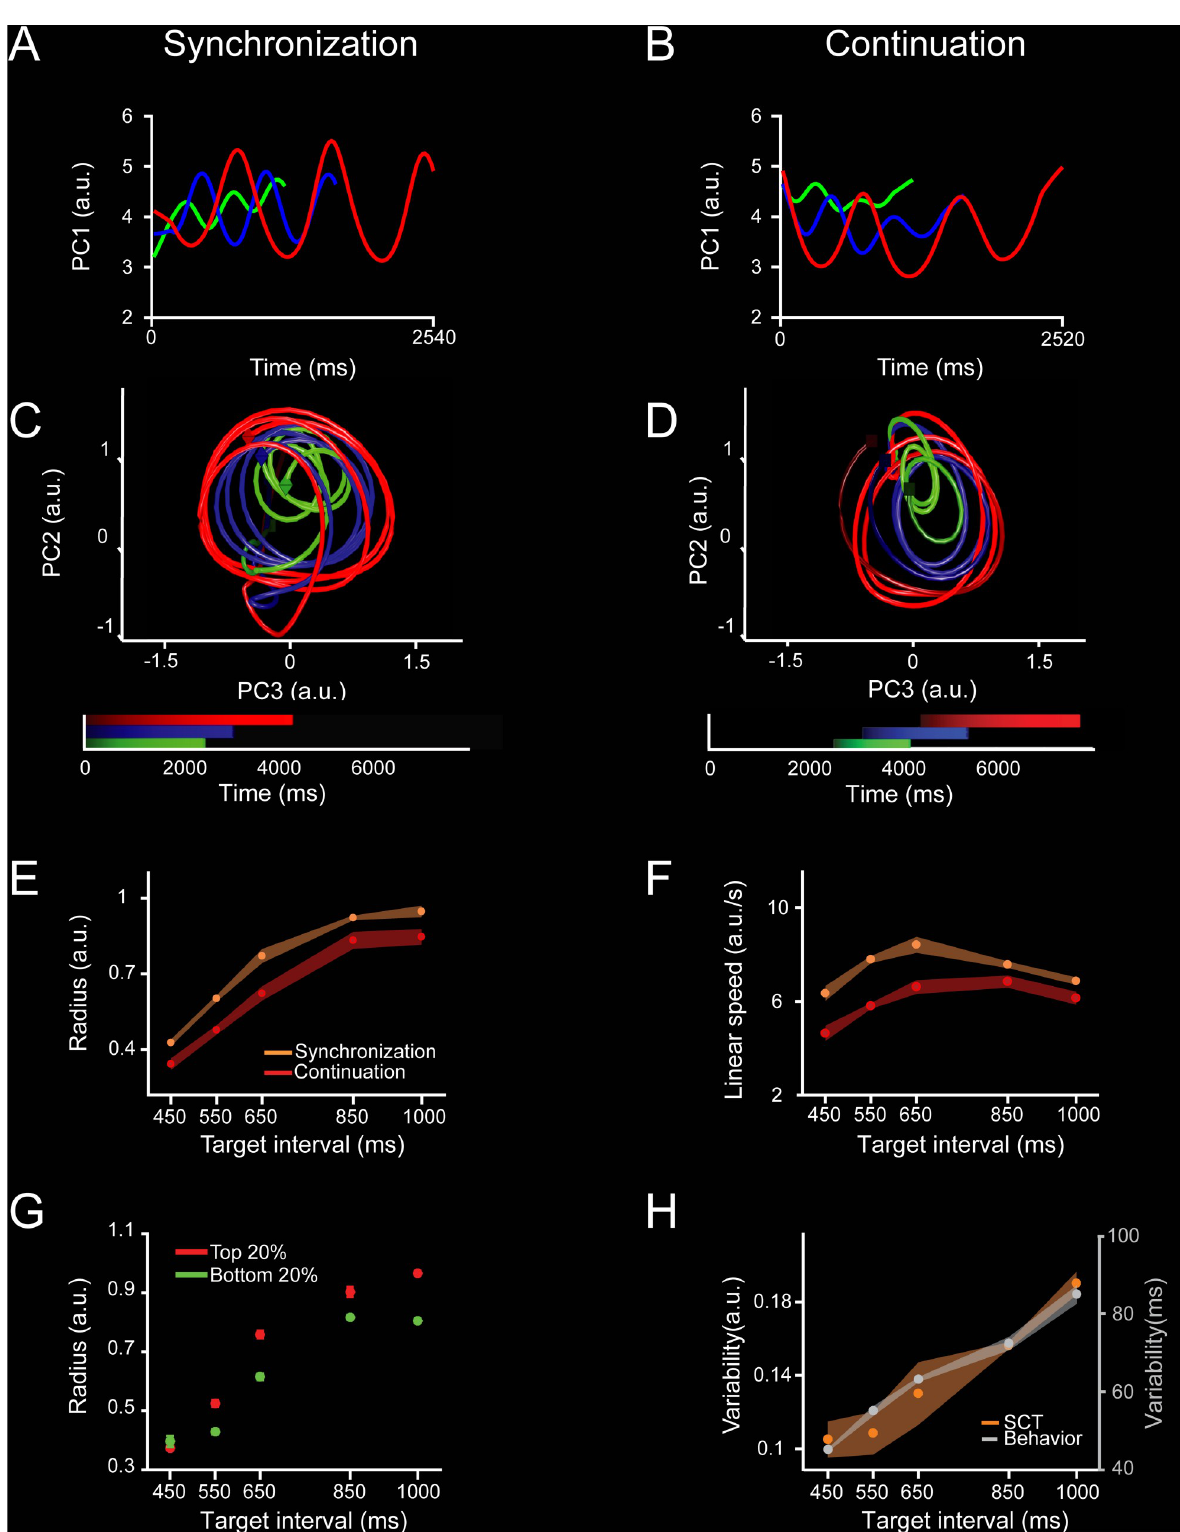
Fig 2. Neural population trajectories during SCT and their oscillatory dynamic properties. A, C . Projection of the neural activity in the MPC (1,477 neurons) during the SC of the SCT onto the first ( A ) or second and third PCs ( C ). The first three PCs explained the 10.7%, 3.8%, and 2.3% of